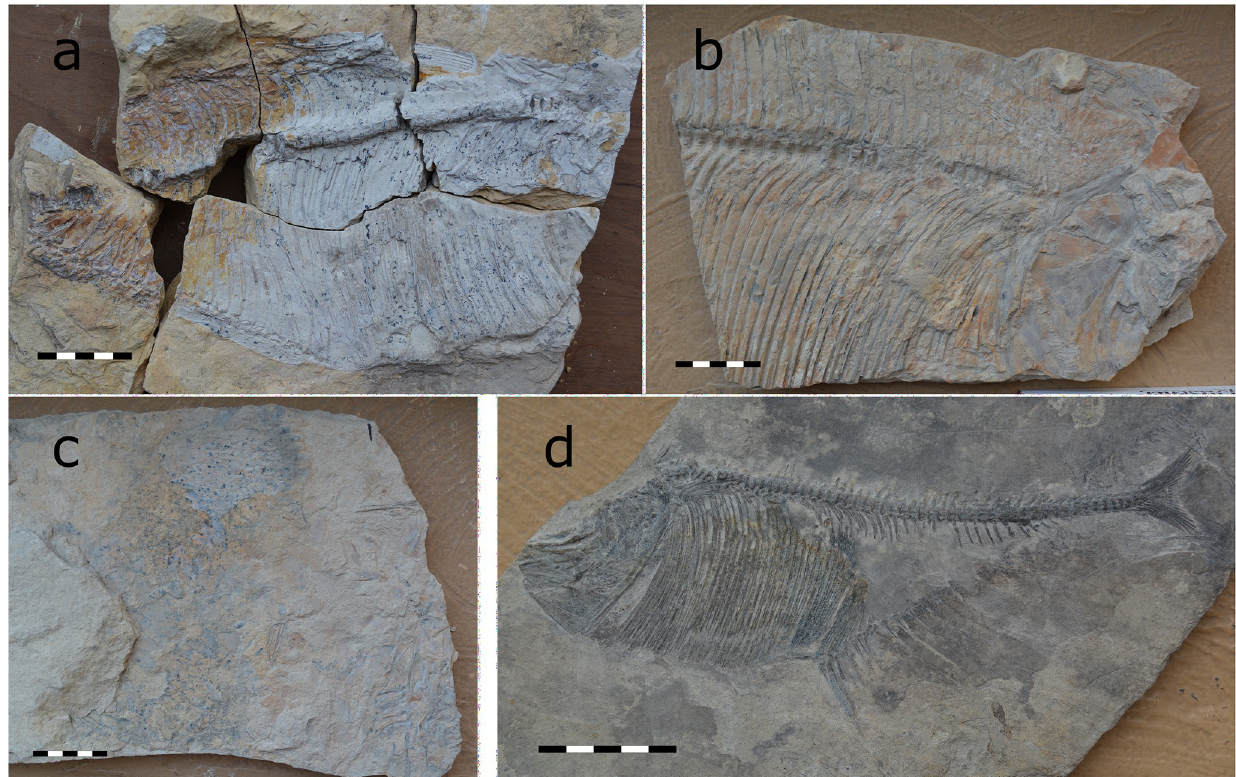
Fig 1. Dixonanogmius sp. from the Middle-Late Santonian Los Temporales locality (CPC-2837) (A) and from the Cenomanian San Carlos quarry (CPC- 2838 and CPC-2836) (B and C). T . formosa from the Turonian Mesa Las Tablas quarry in southern Coahuila (CPC-2835) (D). All scales 50 mm.